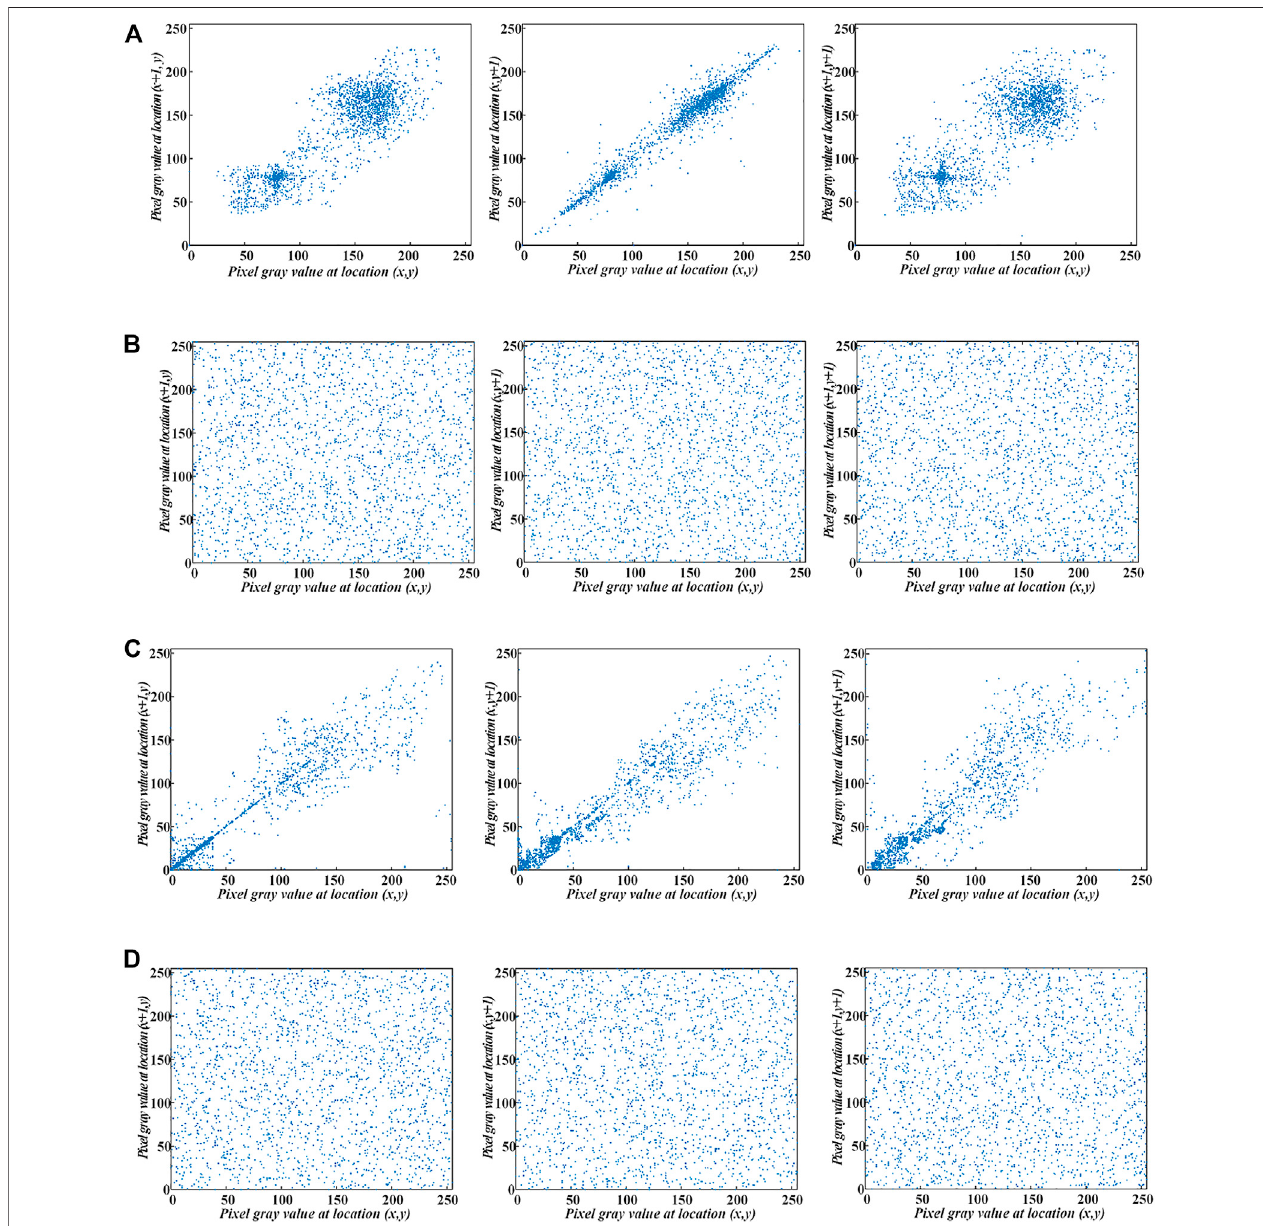
FIGURE9| Correlationofdifferentimages (A) Correlationof2Dimagesplaincube (B) Correlationof2Dimagesciphercube (C) Correlationof3Dimagesplaincube (D) Correlation of 3D images cipher cube.